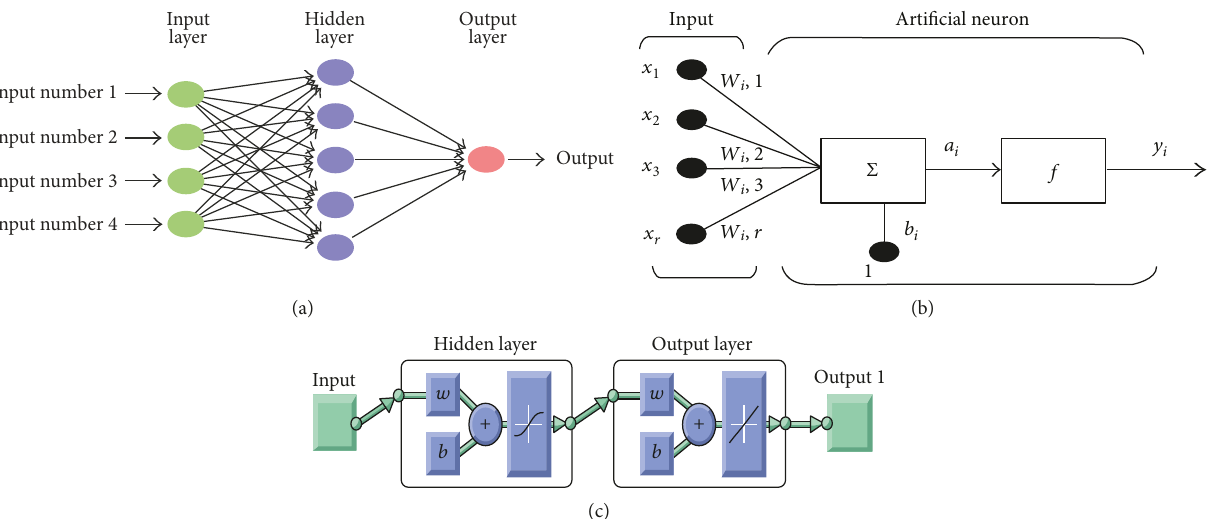
Figure 2: (a) Feed forward neural network. (b) Architecture of an arti fi cial neuron. (c) Diagram of the used FFNN in